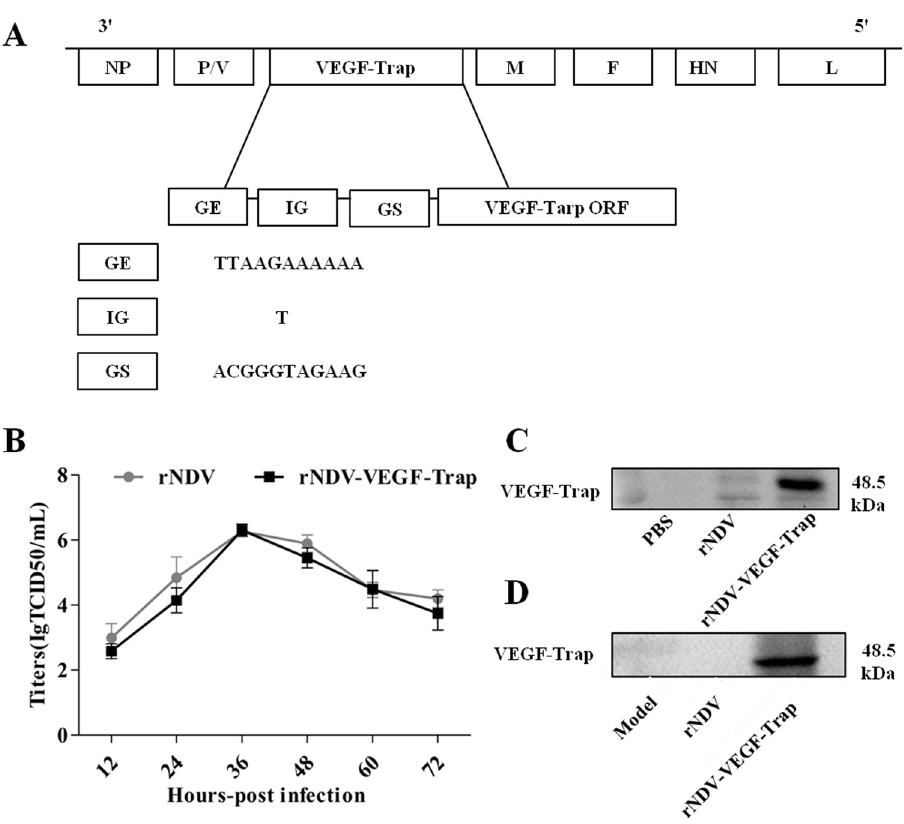
Fig 1. Schematic representation of the genomes, characterization and VEGF-Trap protein of rNDV-VEGF-Trap. (A) Diagram showed insertion of the VEGF-Trap gene into the rNDV genomes at the position between the P and M genes. Recombinant NDV were rescued by transfecting BHK-21 cells with incorporated plasmid along with the helper plasmid PTM-NP , PTM-P and PTM-L . The culture supernatant was harvested at 72h post transfection and inoculated into 10 days SPF embryo chicken eggs. After 3 days, the allantoic fluid was harvested and the titers were determined by hemagglutination Assay (HA) test. (B) Growth curves of rNDV-VEGF-Trap. CT26 cells were infected with rNDV and rNDV-VEGF-Trap at 0.1 MOI. Cell monolayers were lysed at 12, 24, 48, 60 and 72h post-infection for intracellular titer measurement by TCID50. (C) The expression of VEGF-Trap proteins in CT26 cells. CT26 cells were respectively infected with 1 MOI rNDV-VEGF-Trap or rNDV and the control group received PBS. After 24h incubation, cell supernatant and cells resuspended in lysis buffer supplemented with proteases inhibitor were harvested for Western blot. Result showed that the VEGF-Trap expression was detected in the mixture of cell lysate and supernatant. (D) In vivo , tumor tissues were selected from each group and assayed using Western blot. Result demonstrated that the expression of VEGF-Trap in the tumor tissues of rNDV-VEGF-Trap treated group was significantly higher than that in rNDV-treated group and model